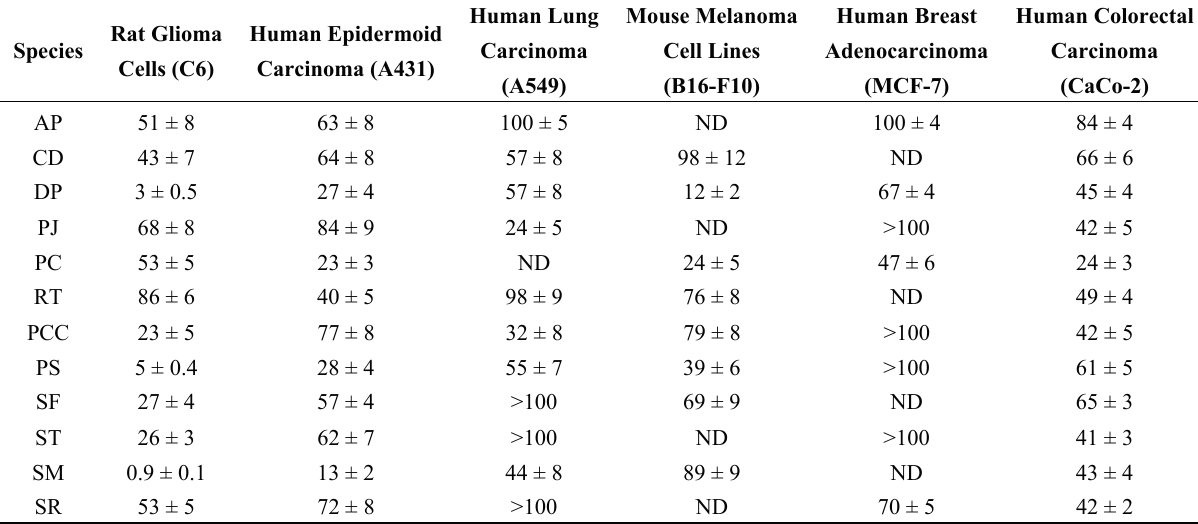
Table 7. Antiproliferative activity IC 50 of the moss ethanol extract on 6 cancer cell lines, expressed as μ g/mL of moss